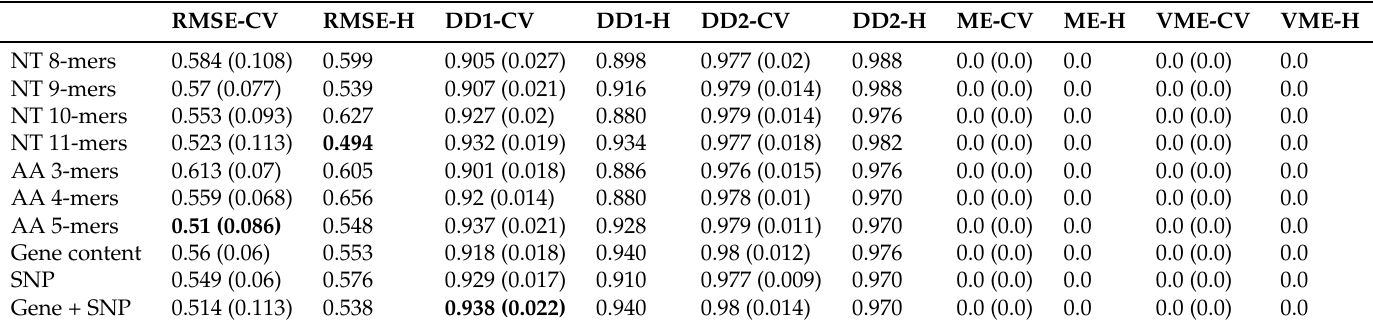
Table A37. K. pneumoniae –levofloxacin.